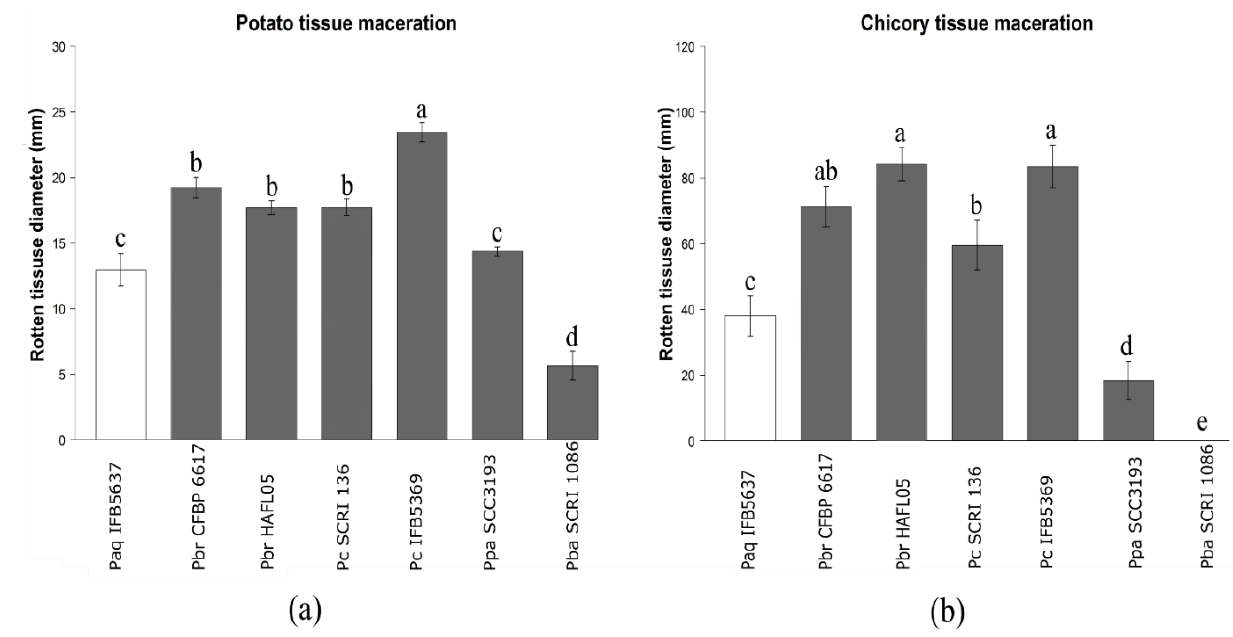
Figure 3. Comparison of the potato ( a ) and chicory ( b ) tissue maceration ability of the tested P. aquaticum IFB5637 strain isolated from water in Poland in contrast to the closely related Pectobacteriaceae strains. Strains abbreviations: P. aquaticum (Paq IFB5637), P. brasiliense (Pbr CFBP 6617, Pbr HAFL05), P. carotovorum (Pc SCRI 136, Pc IFB5369), P. parmentieri (Ppa SCC3193), and P. atrosepticum (Pba SCRI 1086). Means ± SE of diameters (potato) or lengths (chicory) of the rotten tissues are depicted. Three independent experiments with nine technical replications were conducted. Means marked with different letter (a, b, c, d, e) are significantly different according to the Kruskal–Wallis test followed by a post-hoc analysis applying Fisher’s least significant criterion at p < 0.05.